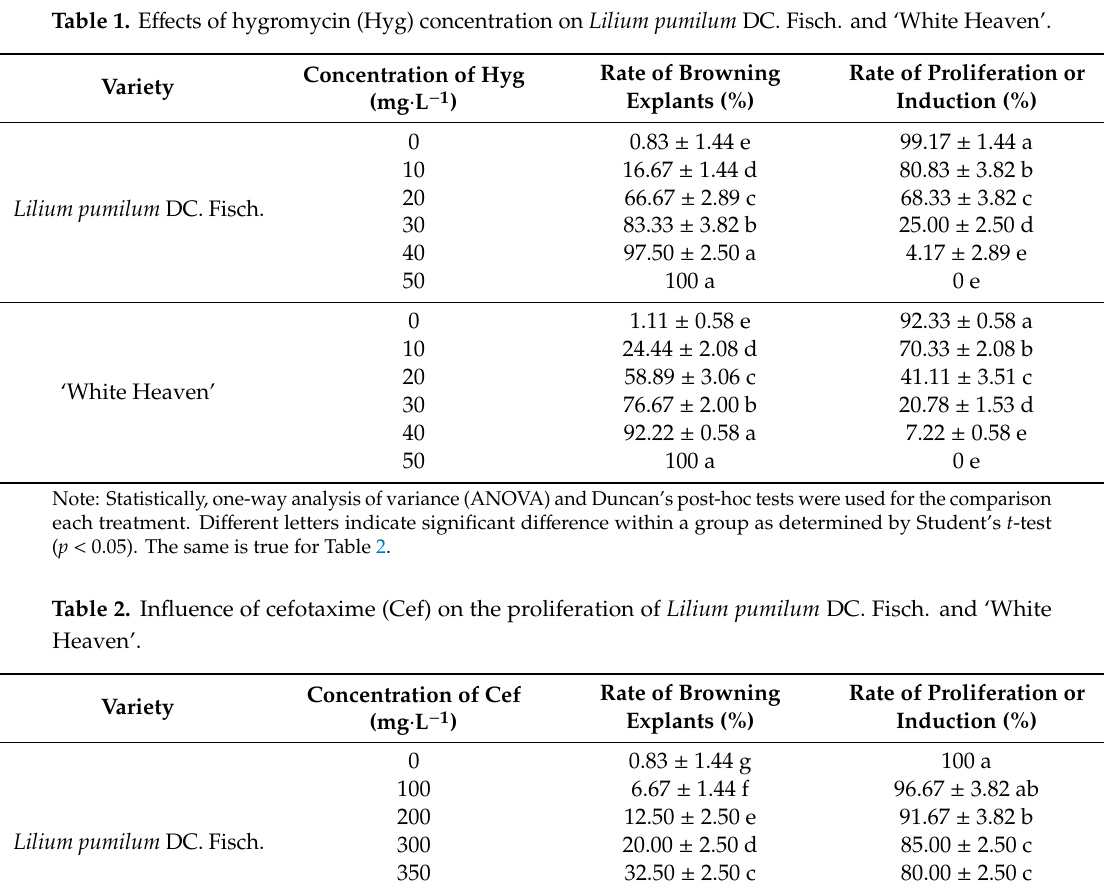
Lilium pumilum DC. Fisch.